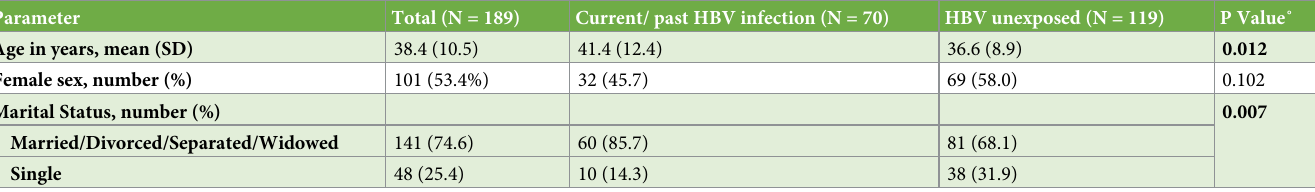
Table 3. Comparison of demographic characteristics of current/past HBV infection to HBV